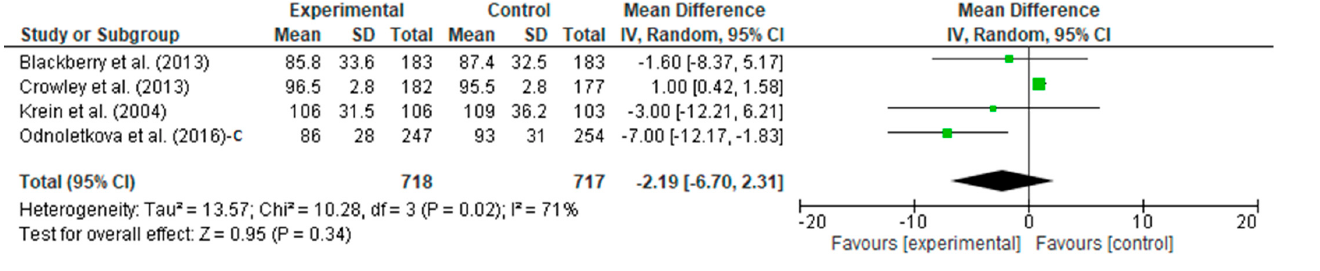
Figure 12. Forest plot intervention vs. control of telecoaching in achieving an LDL outcome [12,13,18,21].